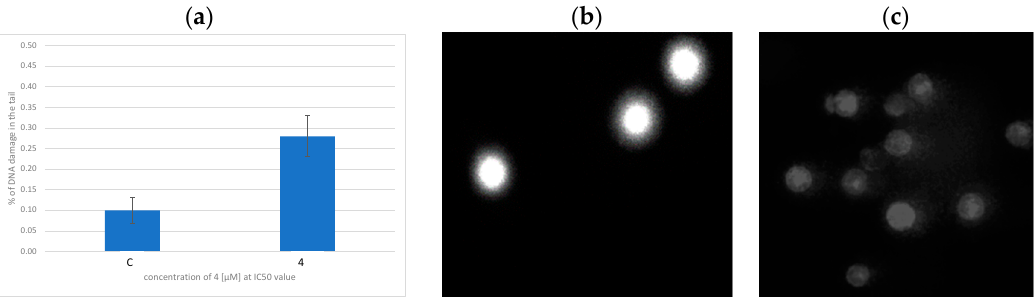
Figure 14. ( a ) Analysis of DNA damage of MCF-7 cells treated with 4 . Morphology of ( b ) control (cells were not treated) and ( c ) damaged MCF-7 cells treated with 4 at an IC 50 of 57 ± 3 μ M.